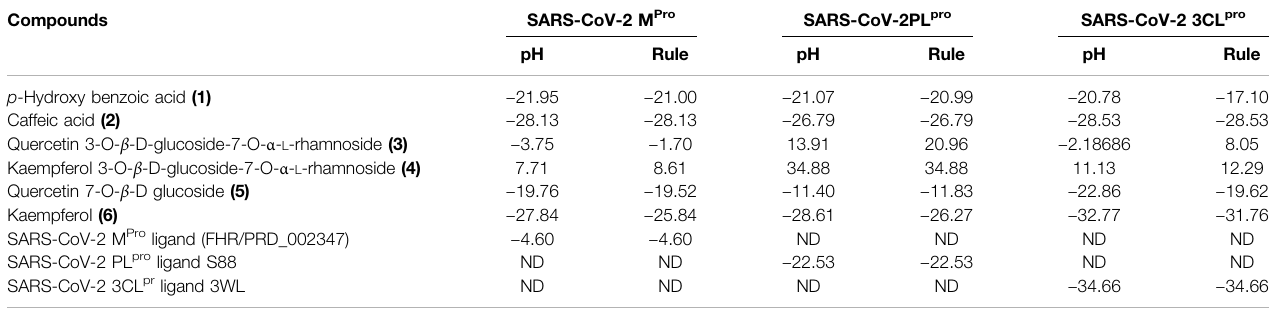
TABLE 4 | Free binding energies ( Δ G) in Kcal/mol of compounds isolated from B. indica Lam. leaves in the active sites of speci fi c proteins that serve as the main targets for SARS-CoV-2 eradication employing in silico studies.